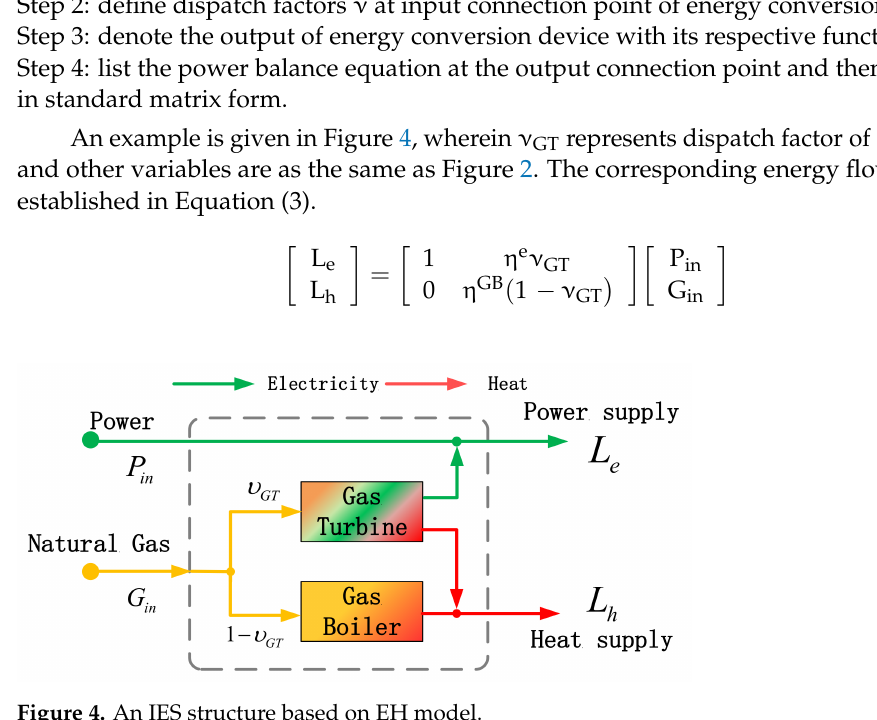
Figure 4. An IES structure based on EH